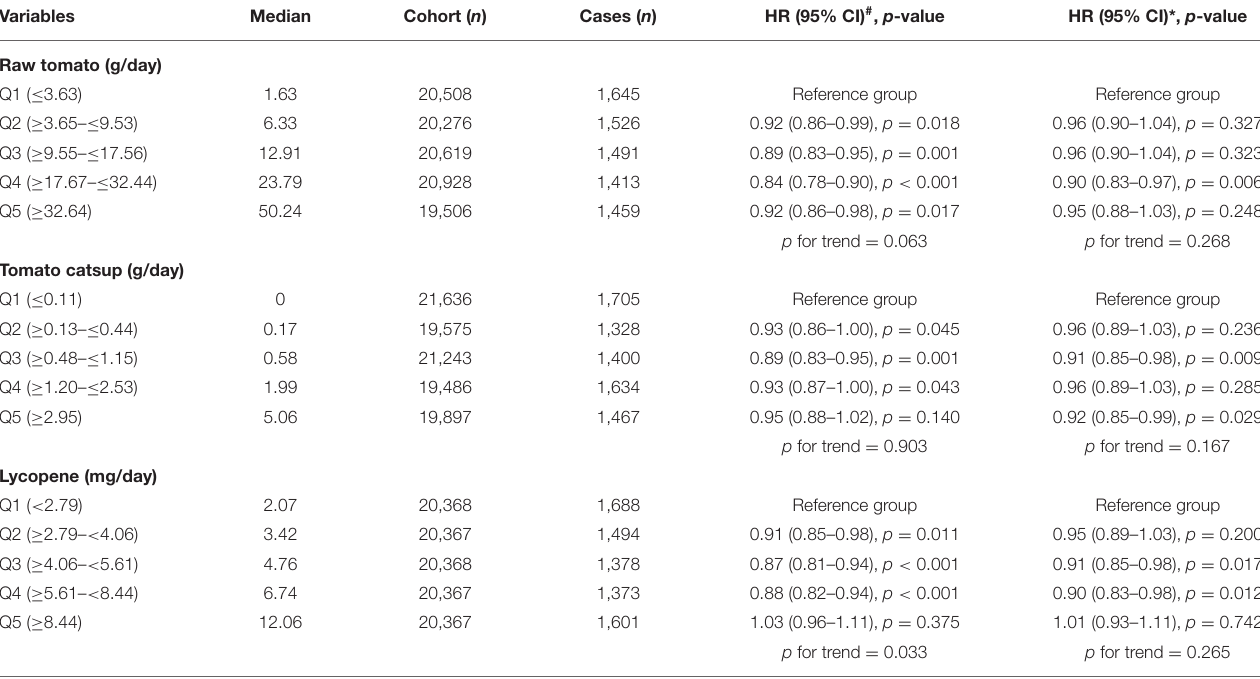
TABLE 3 | Associations between intake of raw tomato, tomato catsup or lycopene, and CVD mortality.